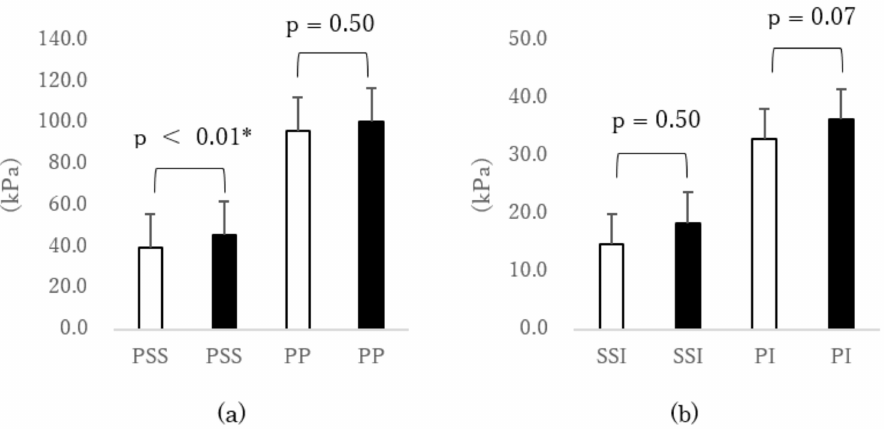
Figure 2. Comparison of external force under the second MTH due to differences in shoe size ( (cid:3) fit size vs (cid:4) 2-cm larger size). ( a ) Peak normal stress (pressure) (PP) and peak shear stress (PSS), ( b ) normal stress (pressure) time integral (PI) and shear stress time integral (SSI), and ( c ) shear stress/normal stress (pressure) ratio of peak value (SPR-p) and shear stress/normal stress (pressure) ratio of time integral value (SPR-i). * p < 0.05 paired t -test. Error bar was standard error (SEM). MTH: metatarsal head. The PSS under the fifth MTH was significantly smaller (p < 0.01, d = 0.42) when putting on shoes of fit width than when putting on shoes of narrower width (Figure 3a). However, significant differences were not observed in the others under the fifth